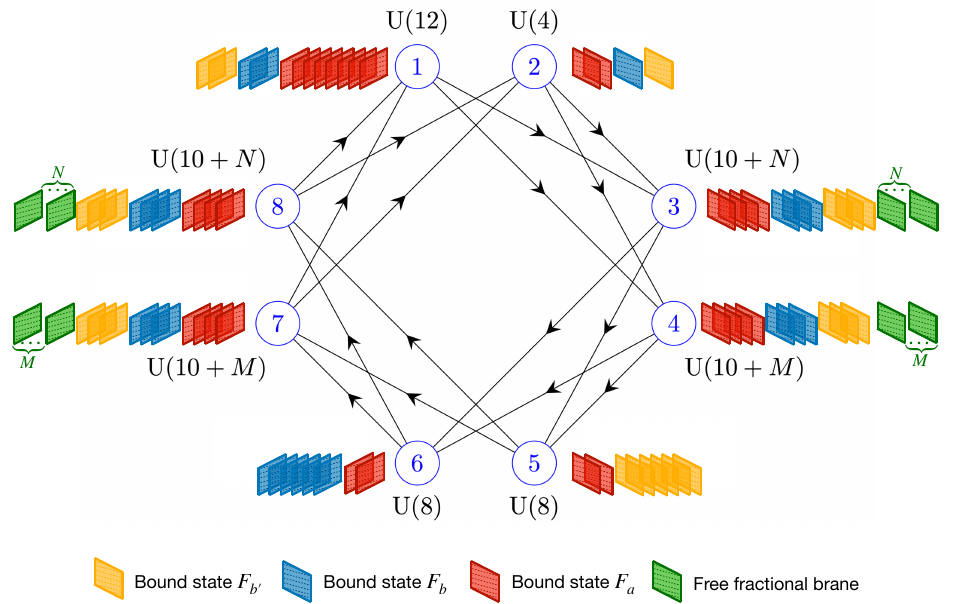
Figure 11 . Model II quiver diagram dP 5 with the bound states 2 F a (red), F b (blue) and F b 0 (orange). Green fractional branes do not participate in any bound